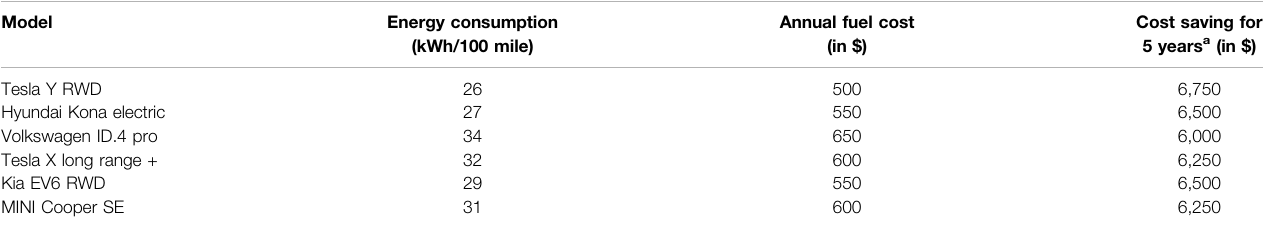
TABLE 13 | Fuel cost comparison of few EV (fueleconomy.gov The of fi cial U.S. government Source, 2021).